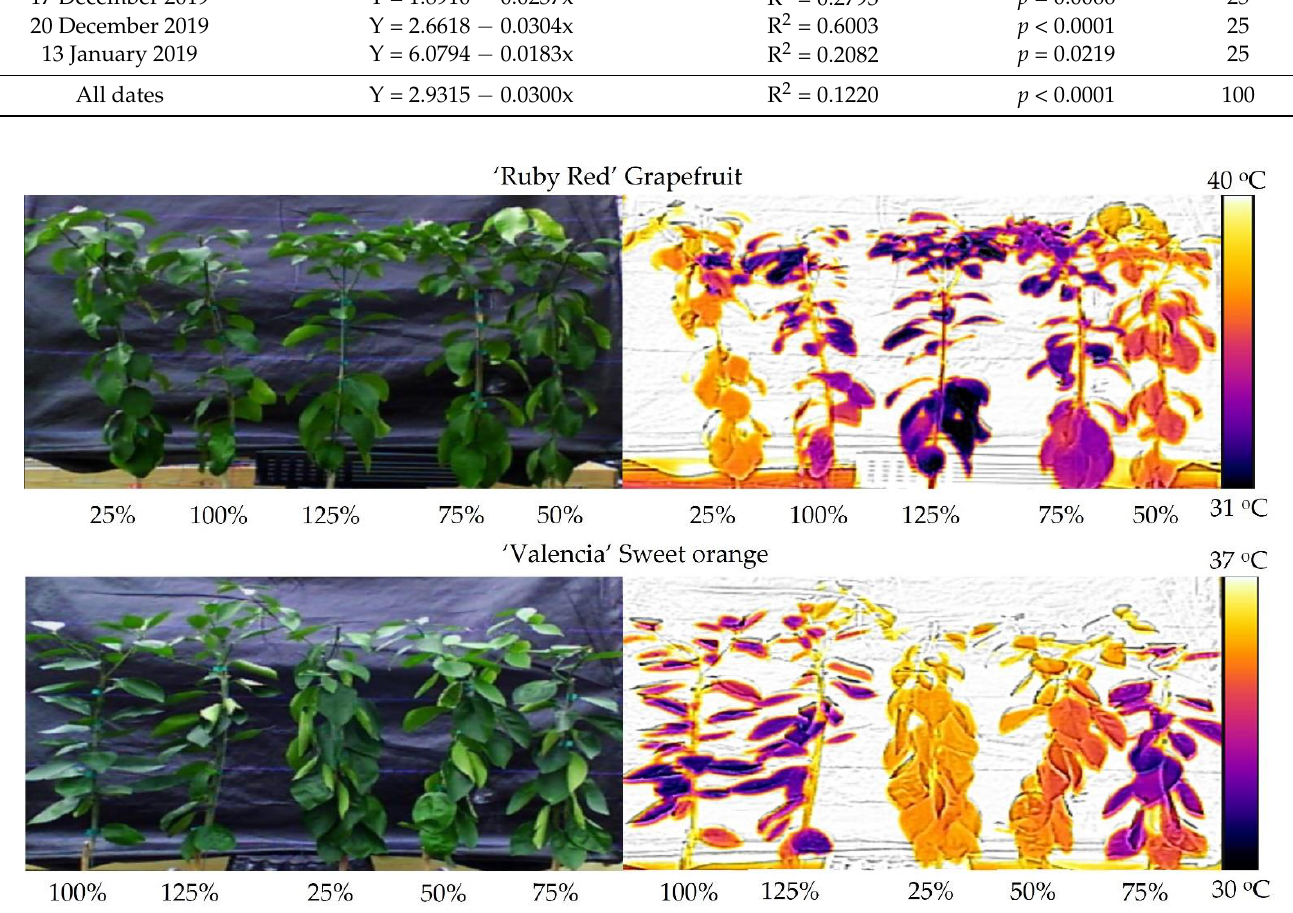
Figure 6. Digital ( left ) and thermal ( right ) images of ‘Ruby Red’ grapefruit and ‘Valencia’ sweet orange plants subjected to different crop evapotranspiration treatments.